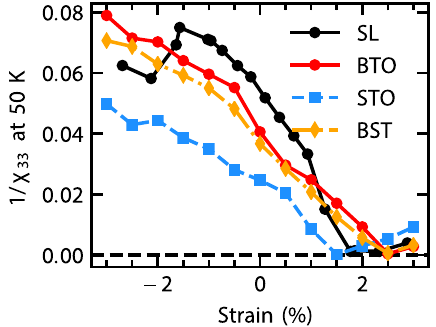
Fig. 3 Inverse out-of-plane dielectric susceptibility. Inverse out-of- plane dielectric susceptibility χ (cid:2) 1 for bulk STO (blue squares), bulk 33 BTO (red circles), bulk BST (orange diamonds), and the SL (black circles). The strain is calculated with respect to the same equilibrium lattice constant de fi ned in the “ Methods ”